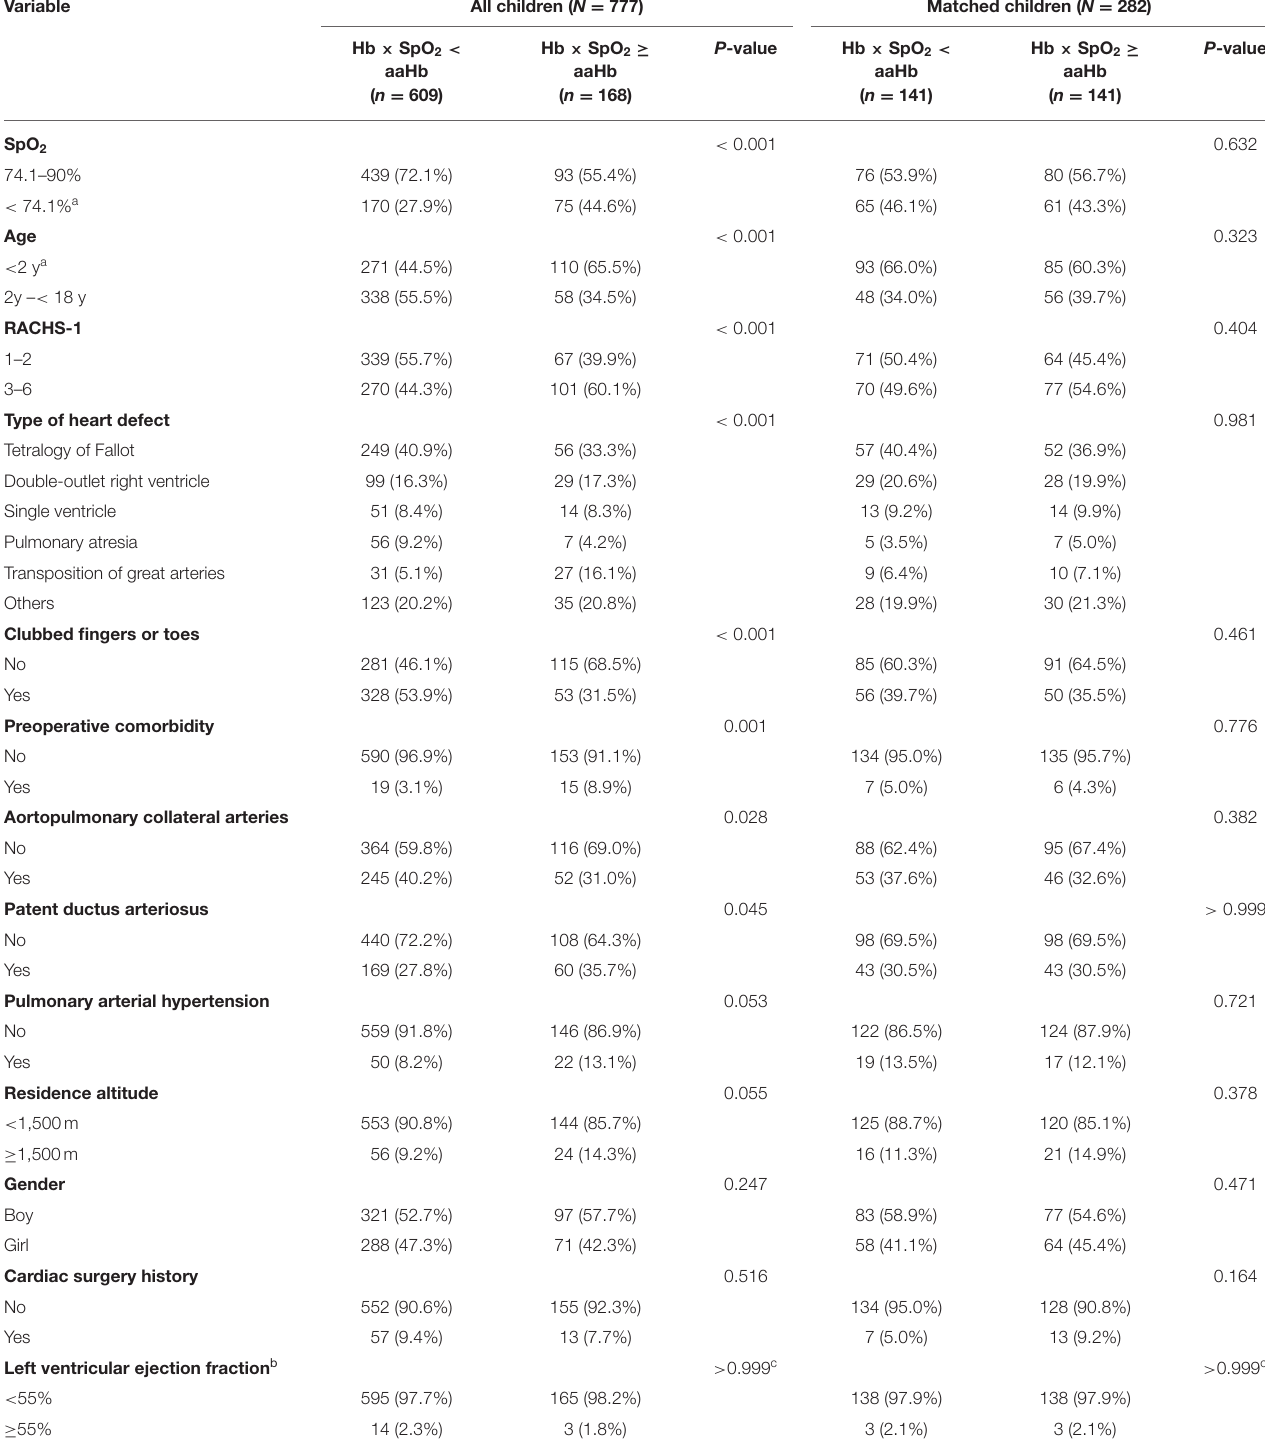
TABLE 2 | Confounding factors associated with the preoperative hemoglobin level in cyanotic children.